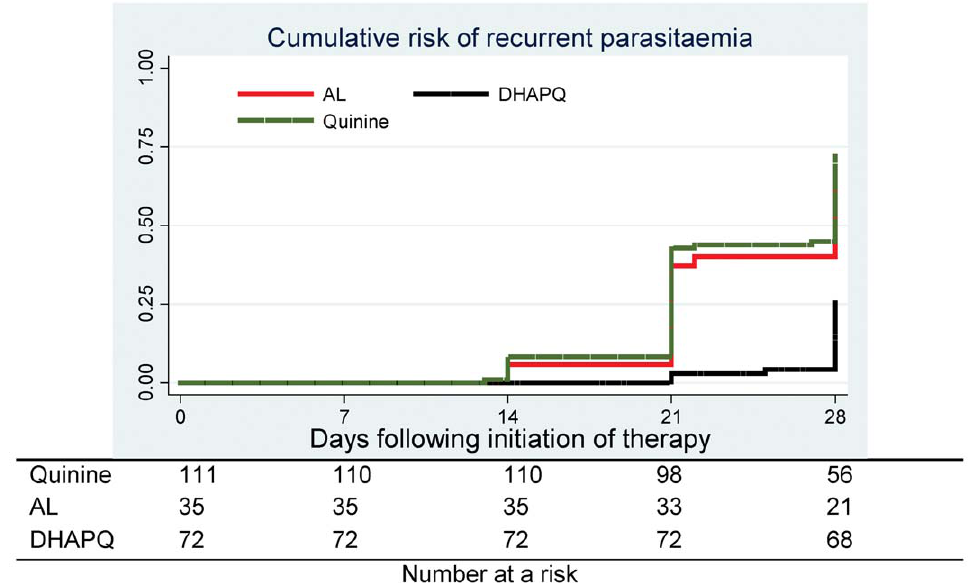
Figure 3. Cumulative risk of recurrent parasitaemia. doi:10.1371/journal.pone.0053772.g003 PLOS ONE |